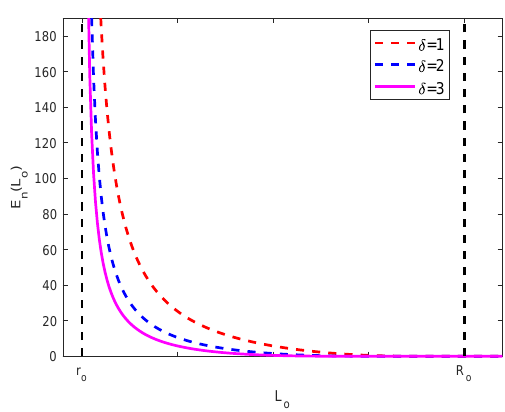
Figure 3. The curve of B n ( L o ) .